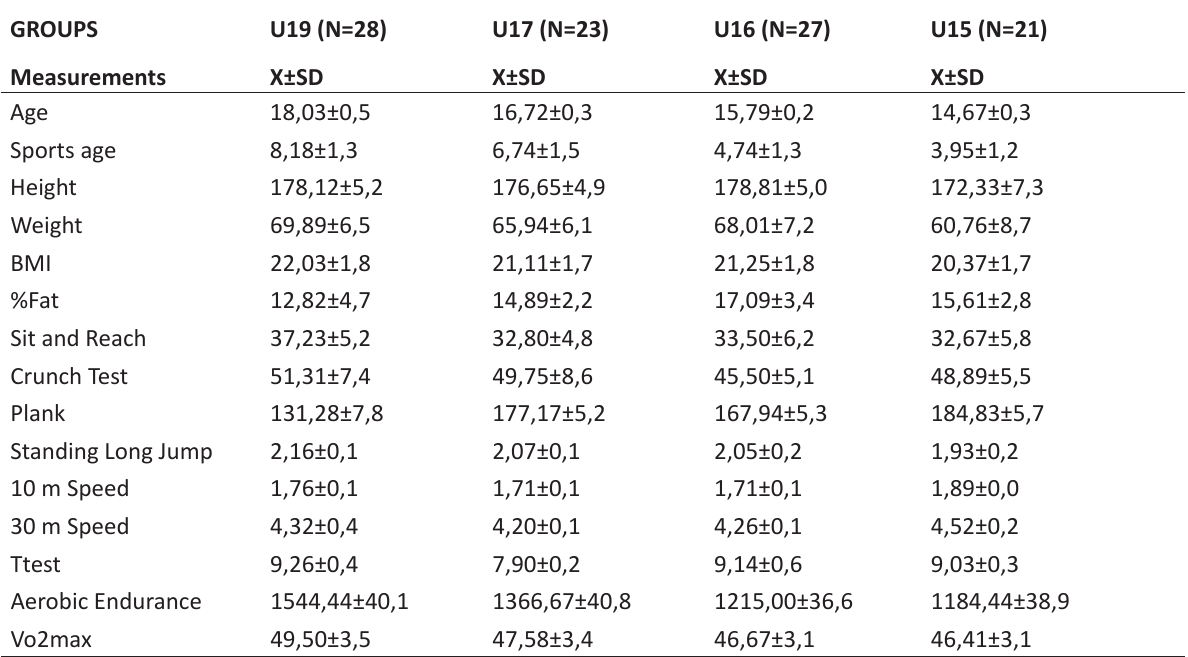
Table 1. Test measurement results of the groups GROUPS